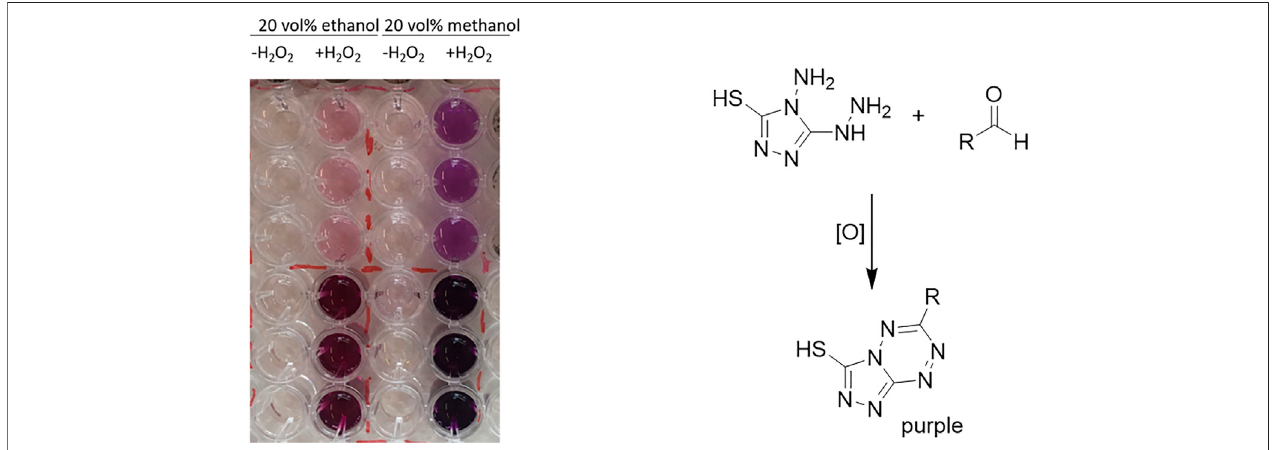
FIGURE 2 | Purpald assay of r Aae UPO-catalyzed oxidations of methanol and ethanol. Reaction conditions: [MeOH or EtOH] = 20 vol%, [KPi, pH 6] = 100 mM, [puri fi edr Aae UPO]=1 μ M,and[H 2 O 2- feed]=4 mMh − 1 ;reactiontime=1.5 h.Foranalysis,thereactionmixtureswerediluted40×fold(upper3rows)or4×fold(lower3 rows) and then incubated for 1 h at room temperature with the purpald reagent. The negative control is left of the enzyme-containing sample.